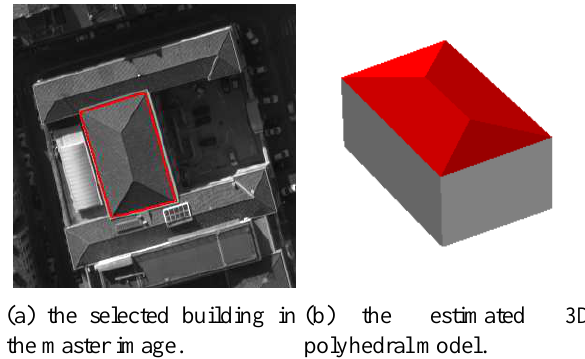
Figure 13. Estimated 3D polyhedral building model and related